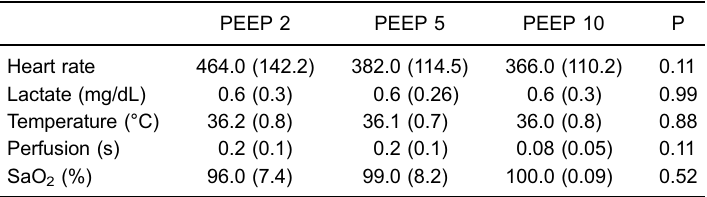
Table 2. Mean values of cardiopulmonary parameters and saturation for different fi nal positive end-expiratory pressure (PEEP)